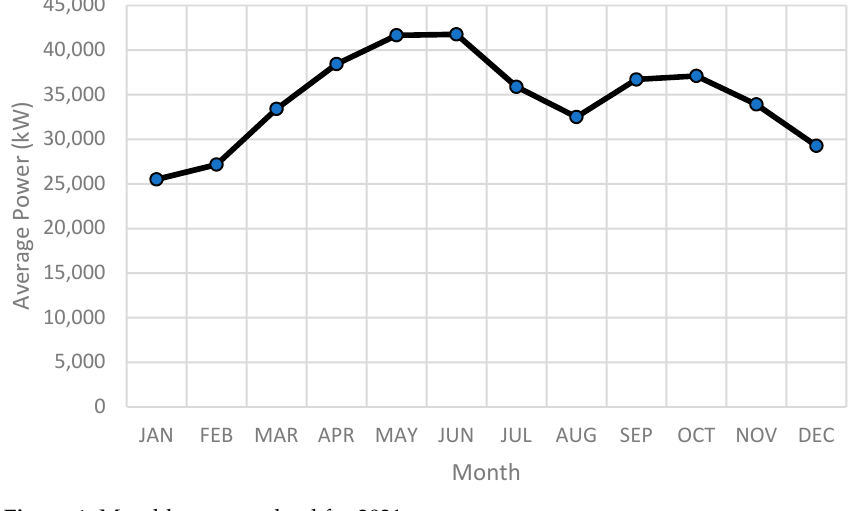
Figure 1. Monthly average load for 2021.